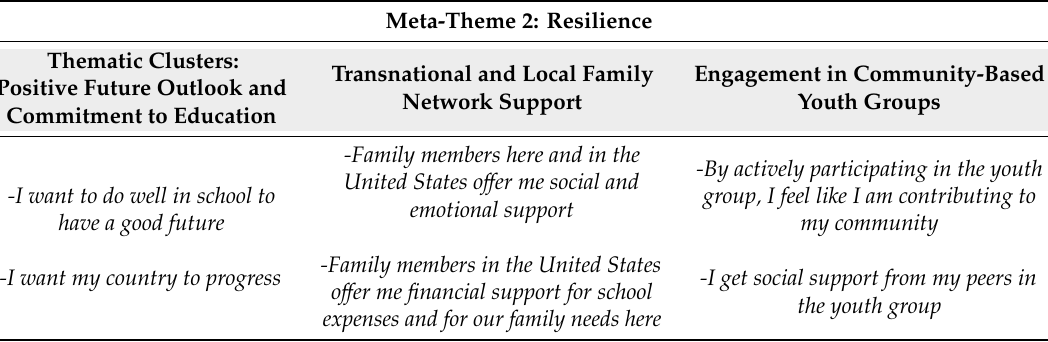
Table 2. An overview of descriptive subthemes (first-level thematic analysis), thematic clusters (second-level thematic analysis) and second meta-theme (third-level thematic